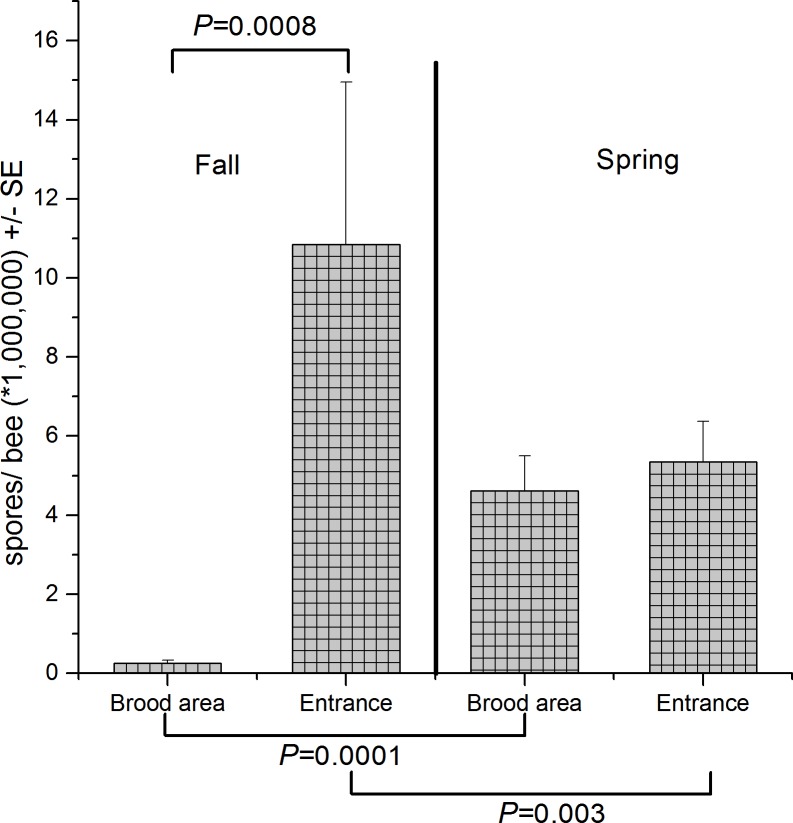
Interaction between season (fall and spring) and sampling location (brood area and entrance) (see Table B in S1 File) on mean abundance of Nosema (± standard error).Results of slices are indicated above the bars for sampling location and below the bars for season, (horizontal lines indicate significant slices). Data represent pooled values for indoor and outdoor samples.